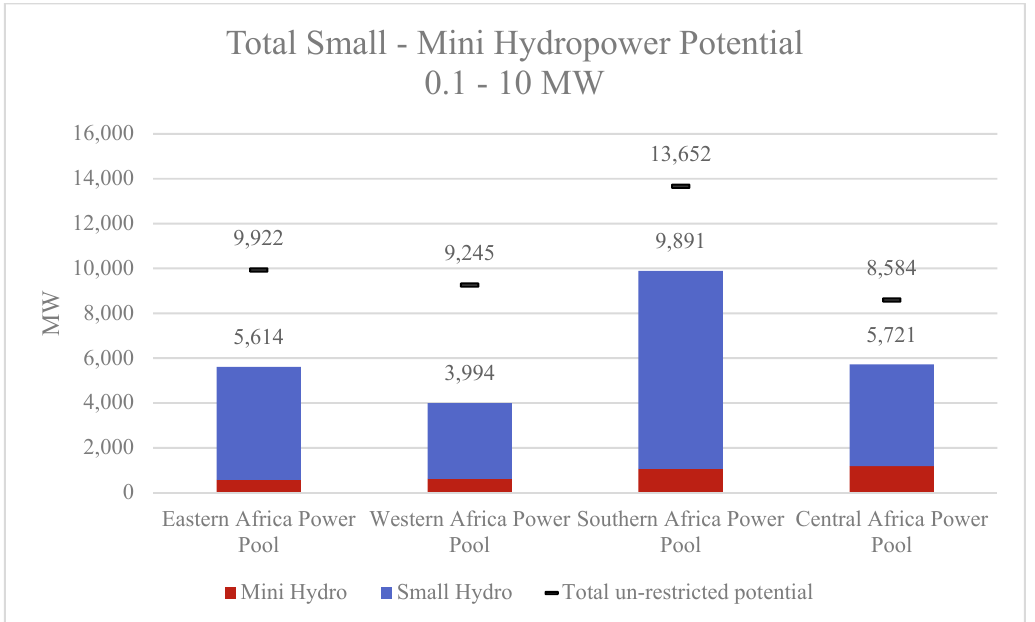
Figure 8. Small-scale hydropower potential per African power pool (detailed description of the countries per power pool is available in Appendix A).